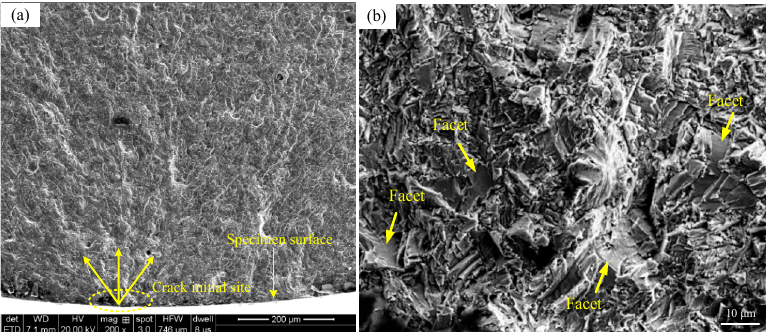
Figure 10. Crack initiation region under the SI surface condition: ( a ) crack initiation site and ( b ) small facets.